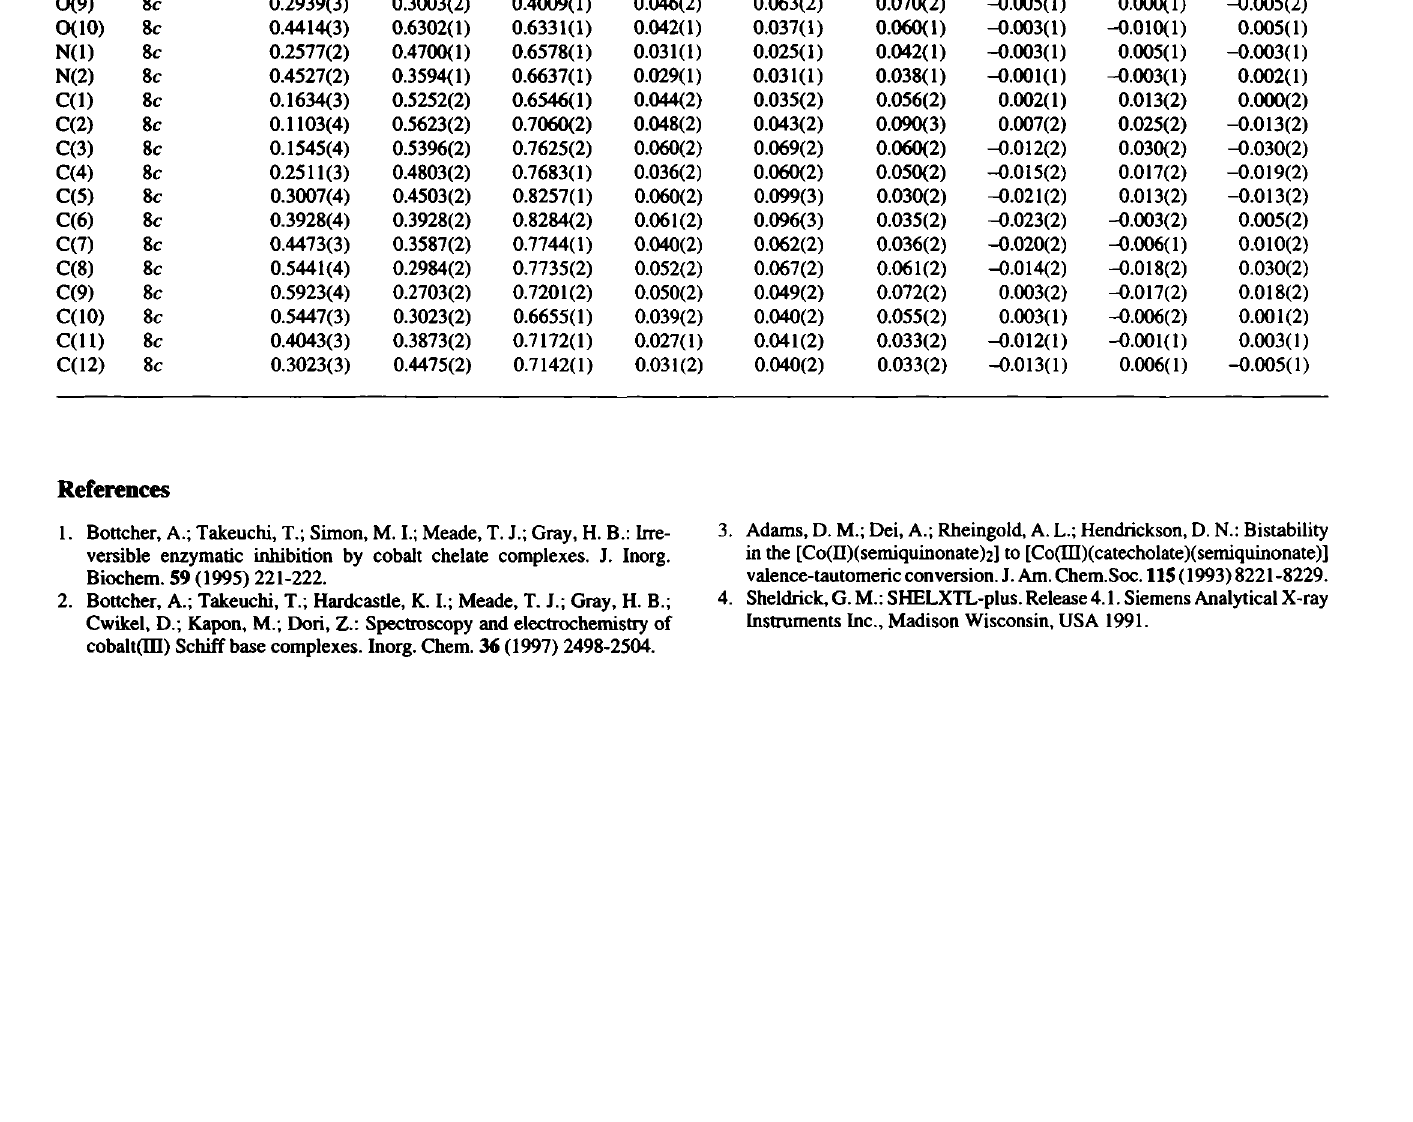
Table 3. Atomic coordinates and displacement parameters (in À 2